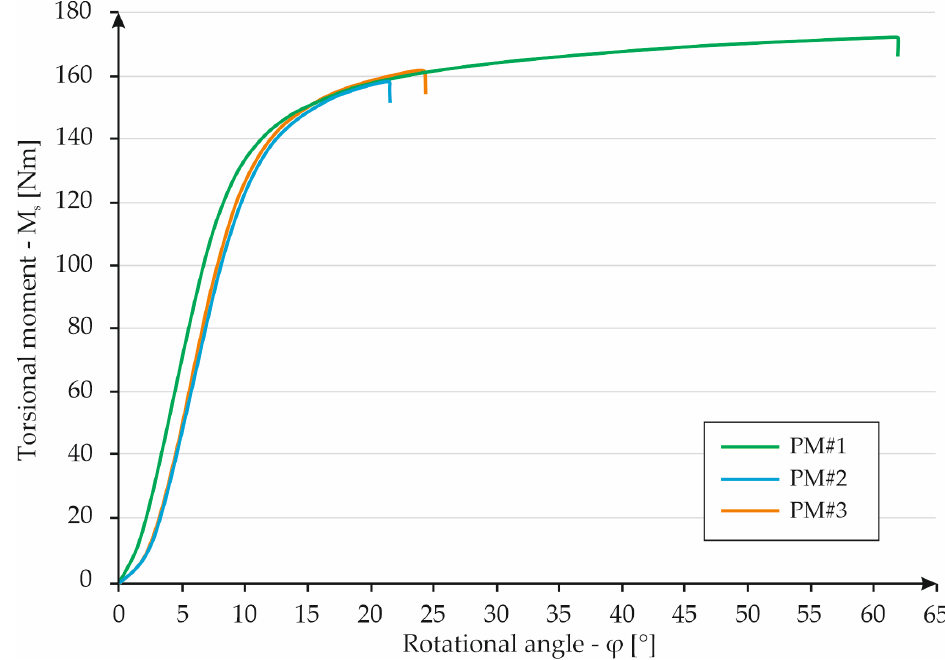
Figure 13. Graph showing the dependence of torque on torsion angle for MS specimens. The torsion test of the S06 specimen series indicated a similar behavior of the test samples in all three cases. Due to their very thick structure, the specimens broke at quite small angles. Specimen S06#1 failed at a torque of 9.56 Nm and a torsion angle of 4.37°. Sample S06#2 achieved the most favorable result of 9.79 Nm at an angle of 6.97°. The third specimen fractured under a torsional moment of 9.86 Nm, twisting by an angle of 6.17°.